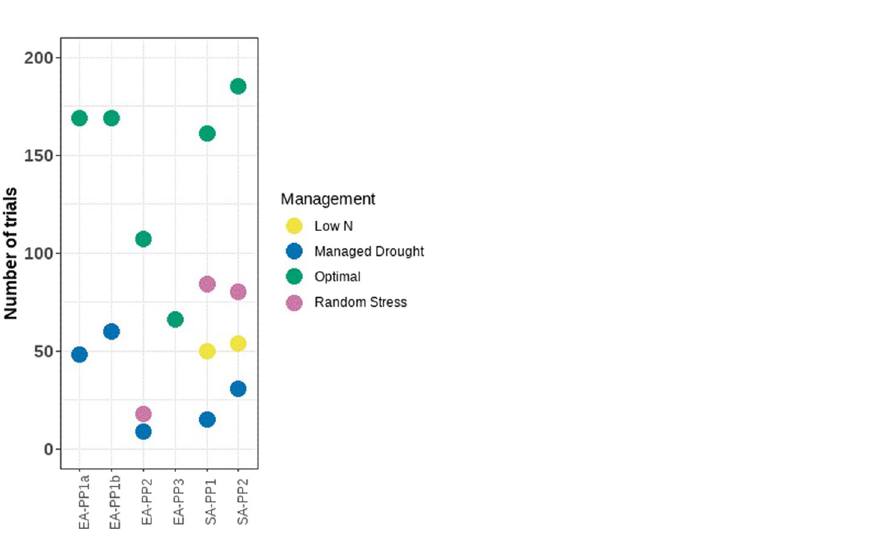
Figure 1. Distribution of trials under different management practices in six product profiles in eastern and southern Africa.